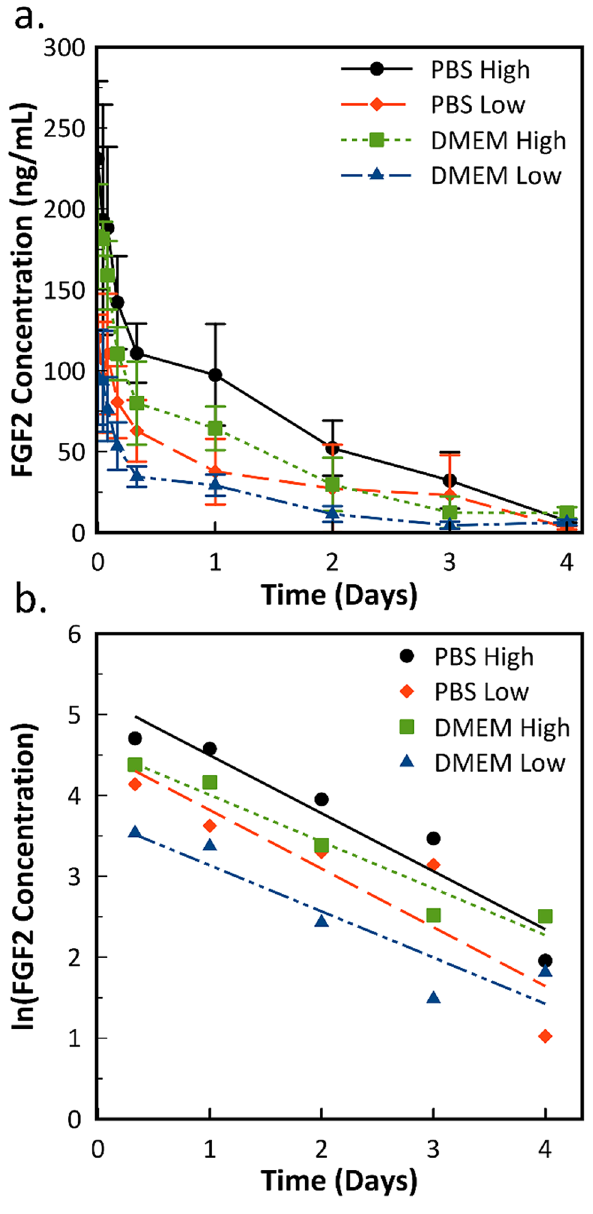
Figure 1. ( a ) ELISA-detectable FGF2 at high (500 ng/mL) and low (250 ng/mL) initial starting concentrations added exogenously to PBS and unmodified DMEM, measured over the course of 4 days. Error bars represent standard deviation (n = 5). ( b ) Natural logarithm of the same average concentration values with a linear fit from 8 to 96 h. The fit line is used to determine the degradation constant to calculate the half-life.